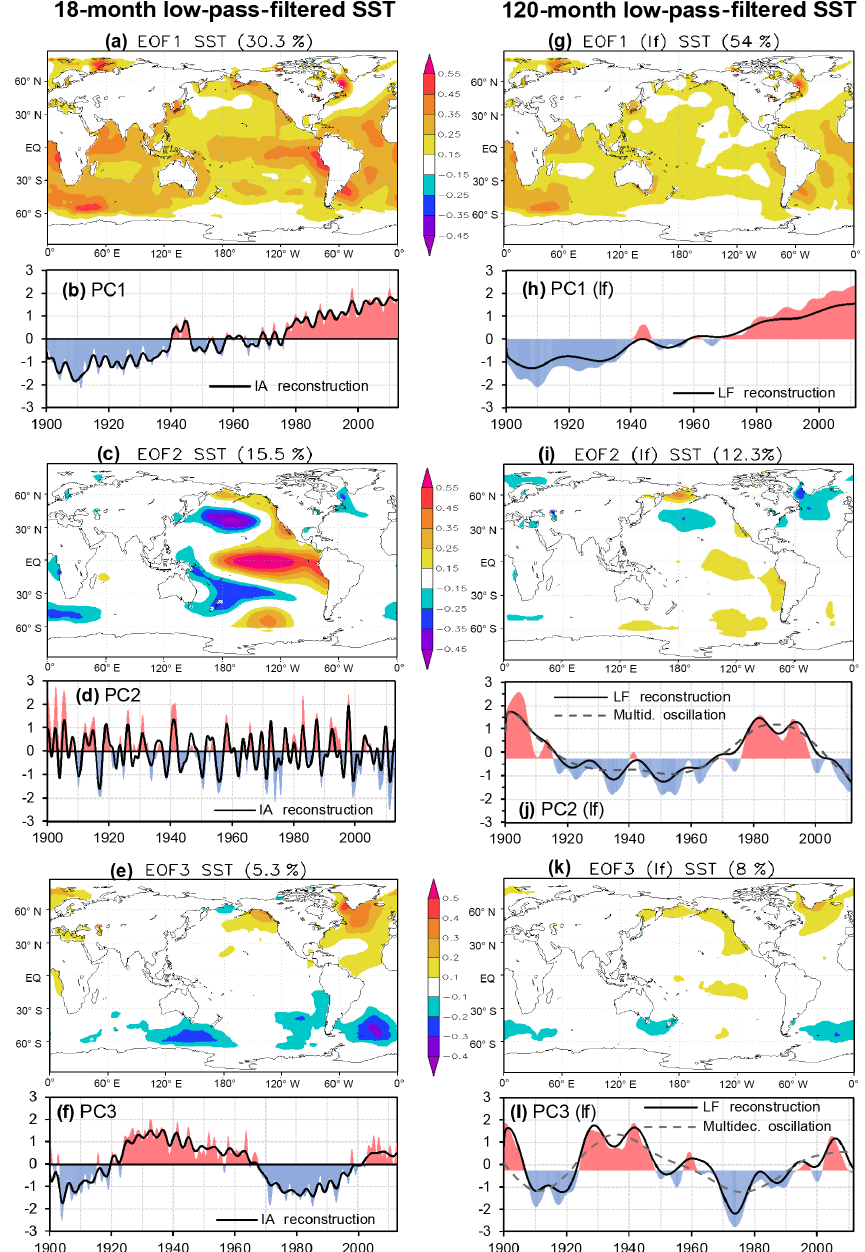
Figure 2. First three leading global pattern of 18- and 120-month low-pass-filtered monthly mean SST between January 1901 and Septem- ber 2012. Patterns are described by the spatial loadings (EOFs) and their associated PCs. The percentage of variance explained by each pattern is given in brackets. The original time series are partially reconstructed using the significant components detected with SSA. Partial reconstructions at interannual timescales are plotted in PCs of the left column (IA reconstruction). Partial reconstructions at low-frequency timescales (LF reconstruction) are plotted in PCs (lf) of the right column. The partial reconstructions include all variability modes at each timescale shown in Table 1. Panels (j) and (l) also show the multidecadal